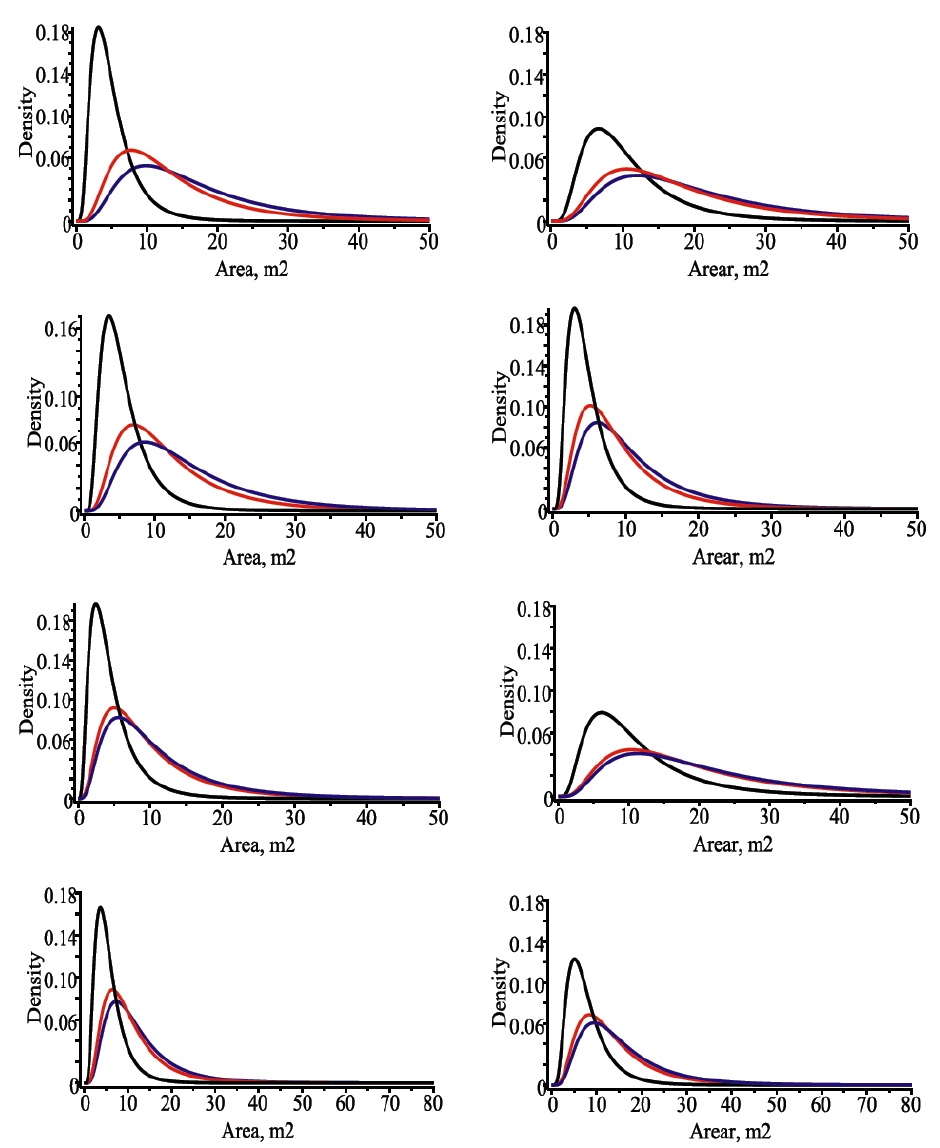
Figure A2. Estimated marginal probability density functions of the potentially available area for two randomly selected stands from a validation dataset: ( left ) first stand; ( right ) second stand; ( 1st row ) all species; ( 2nd row ) pine ( Pinus sylvestris ); ( 3rd row ) spruce ( Picea abies) ; ( 4th row ) silver birch ( Betula pendula Roth and Betula pubescens Ehrh.); black — 30-year-old stands; red — 70-year-old stands; and blue — 120-year-old stands.